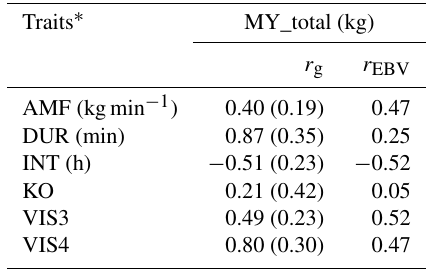
Table 6. Genetic correlations ( r g ) with standard errors and breeding value correlations ( r EBV ) considering bulls with at least five daugh- ters between milk yield and behavior indicator traits.